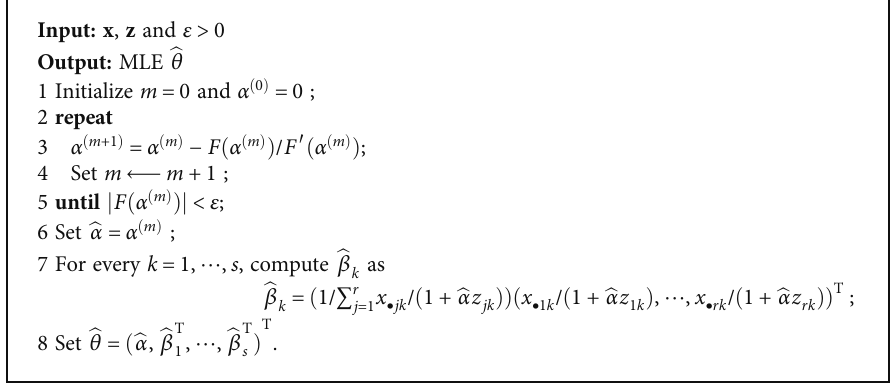
Algorithm 1: PLBA for computing b θ :